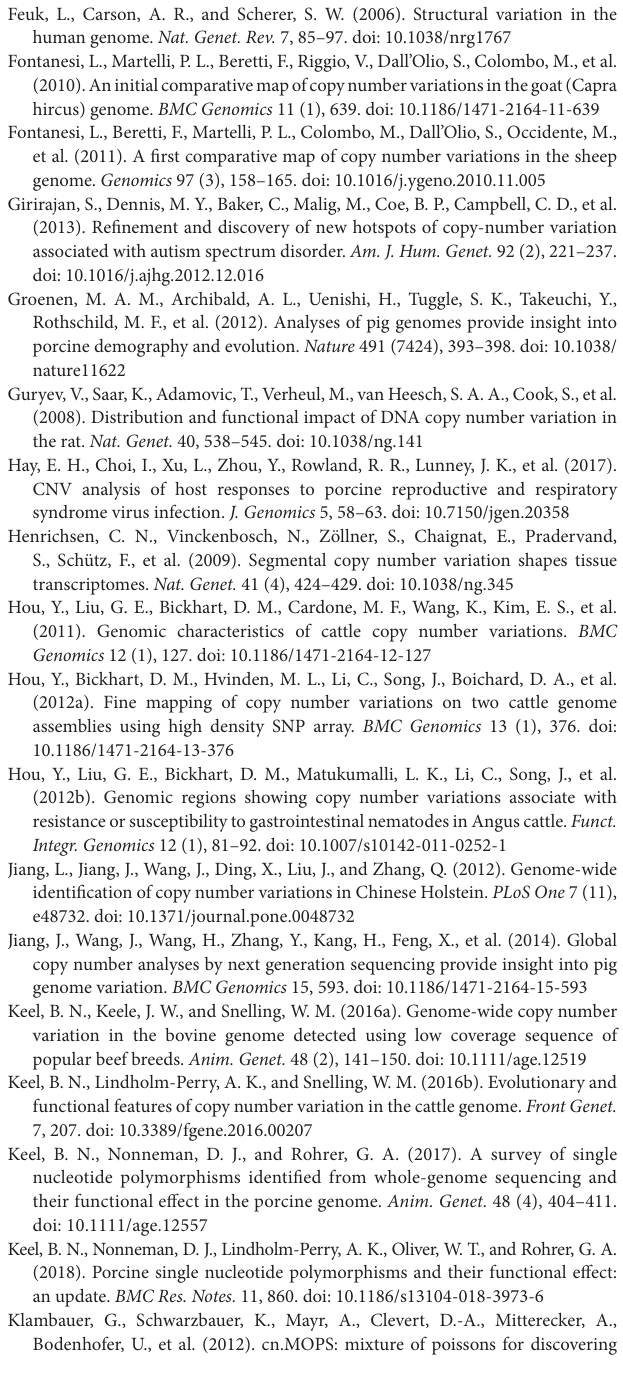
TABLE S6 | Results from GO enrichment analysis. TABLE S7 | Results from QTL enrichment analysis using QTL from the AnimalQTL Database. TABLE S8 | Results from QTL enrichment analysis using previously identified QTL in the USMARC swine